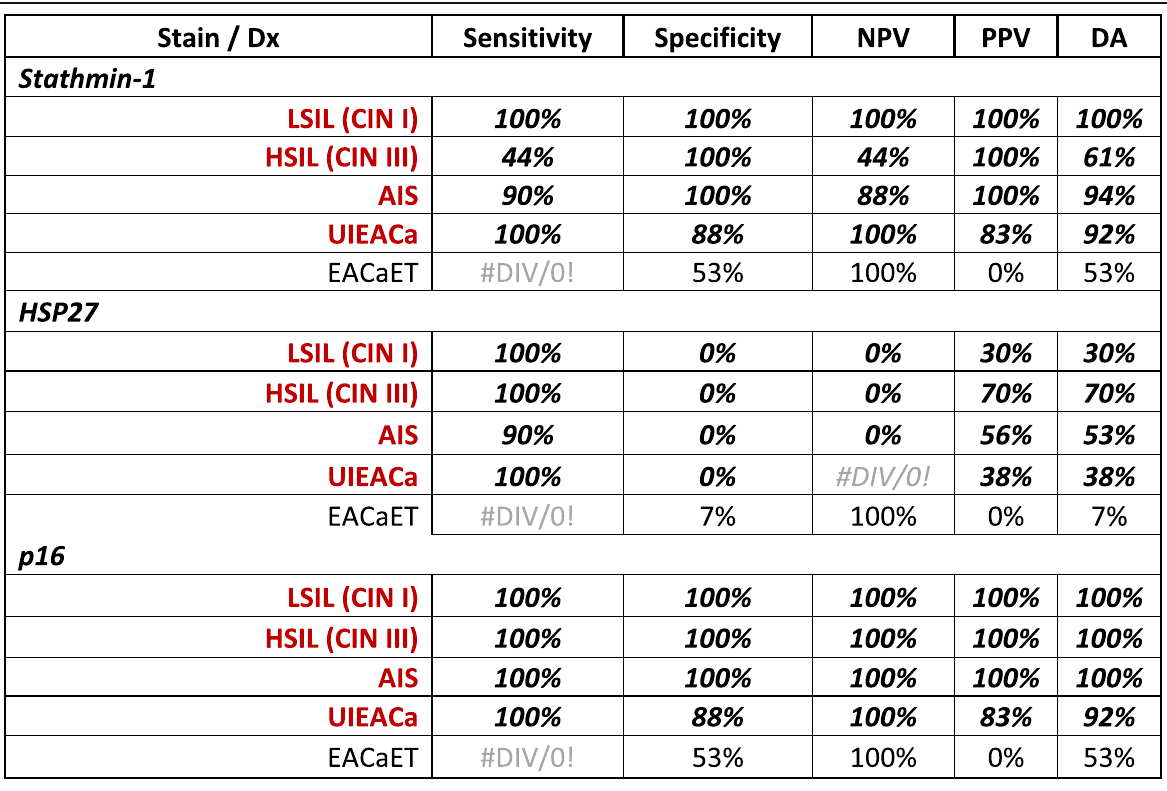
Table 2 Test performance of the three stains for each histopathology diagnostic